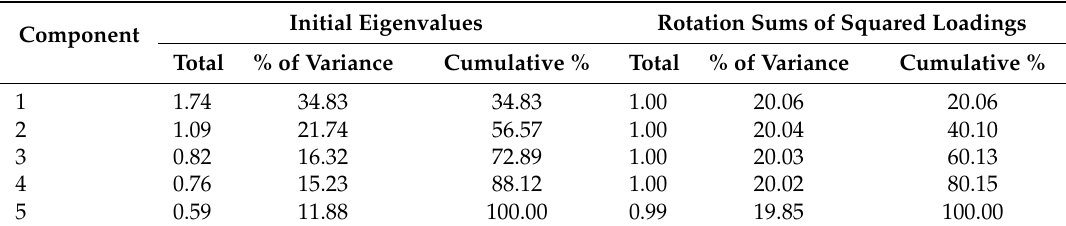
Table 3. Total variance explained of the logging responses of core samples from the No. 11 and No. 5 coal in the HC block. Extraction method: Principal components analysis (PCA).